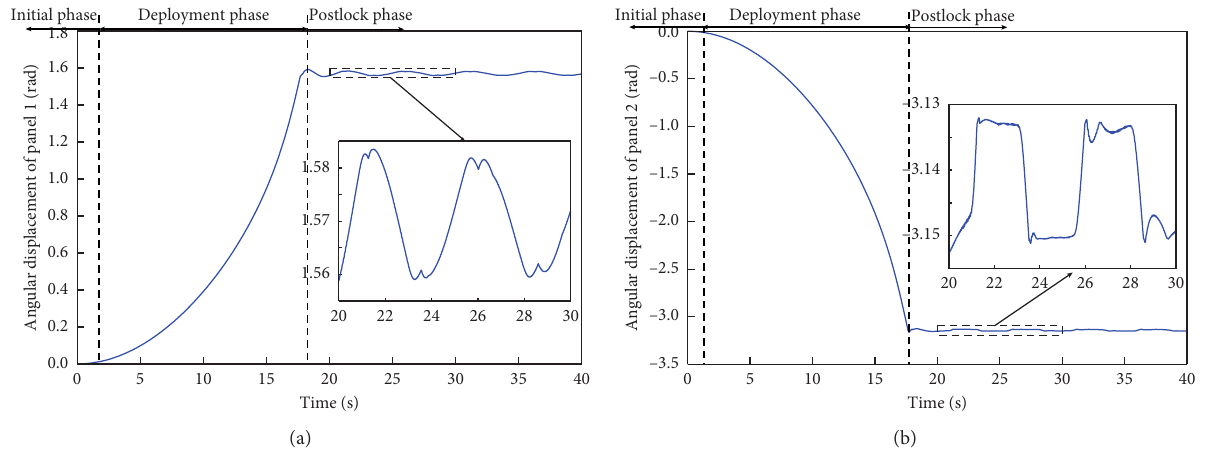
Figure 11: Angular displacements of two solar